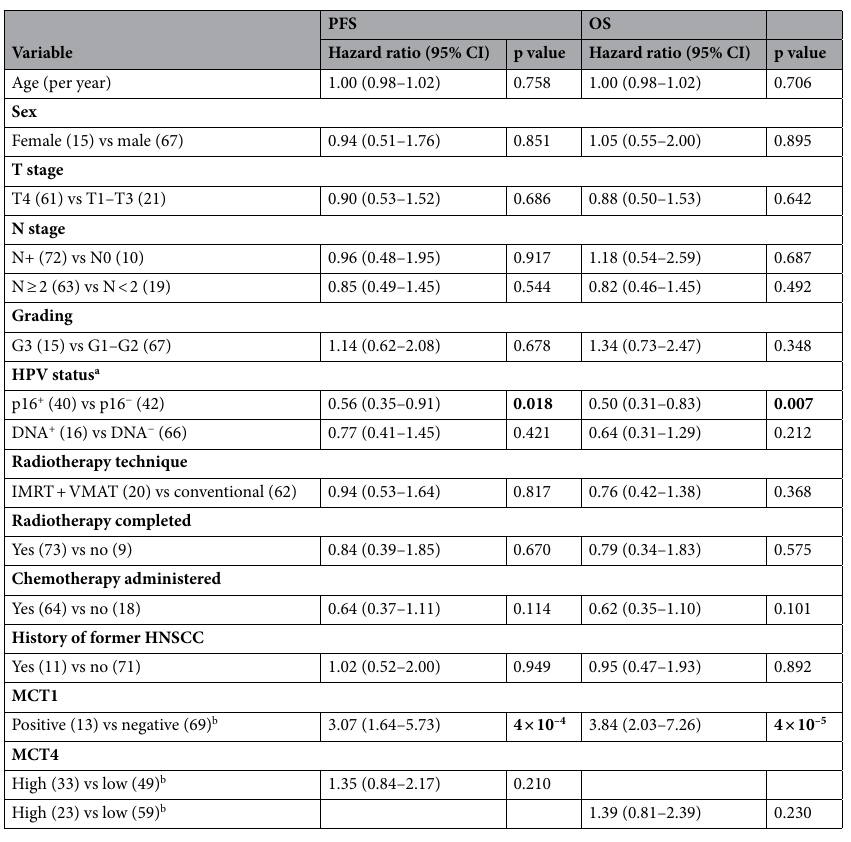
Table 2. Basic patient and clinical features in relation to progression-free (PFS) and overall (OS) survival assessed by univariable Cox regression analysis. P values < 0.05 are indicated in bold. a HPV status was determined both by p16 protein and specifically for HPV-16 subtype by DNA sequencing. Note that other HPV viruses were not covered by this sequencing. b Dichotomic discriminator was determined by “Cutoff Finder”, see “Methods” section. For MCT4, different cutoffs were determined for PFS (score 165 as defined in “Methods”) and OS